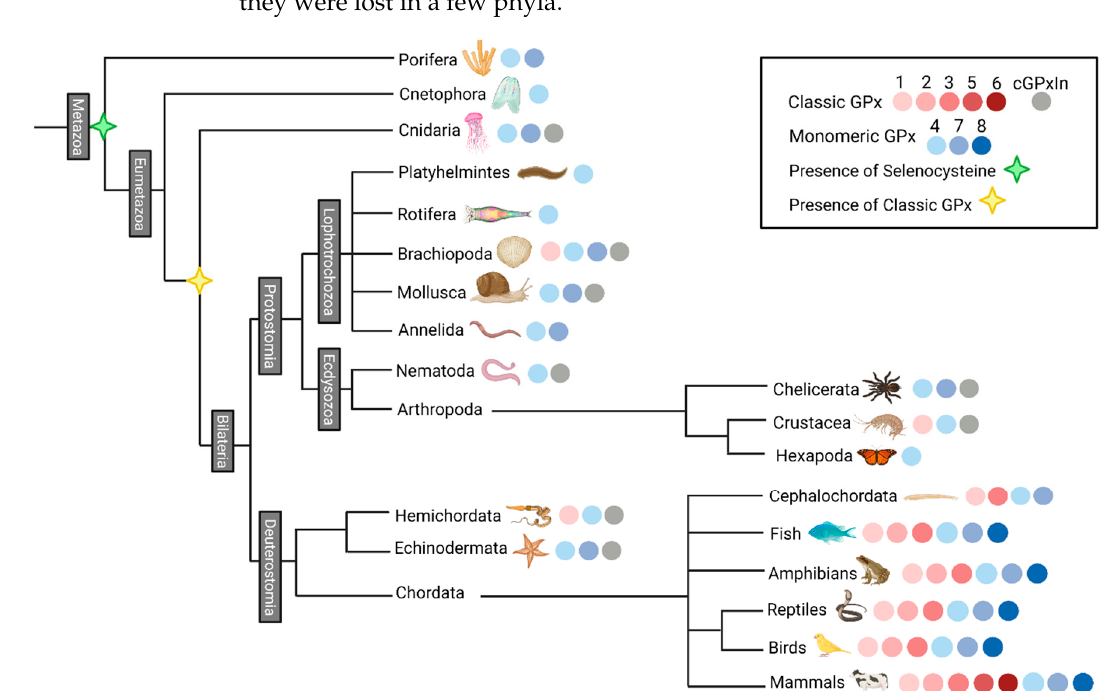
Figure 3. Presence of each type and subtype of glutathione peroxidase proteins found in major animal phylum, or subphylum. Red colors: classical GPx; blue colors: monomeric GPx; gray color: classical GPx from invertebrates (cGPxIn); green star: introduction of selenocysteine at the GPx catalytic site; yellow star: supposed arising of classical GPx. Figure created with BioRender.com.